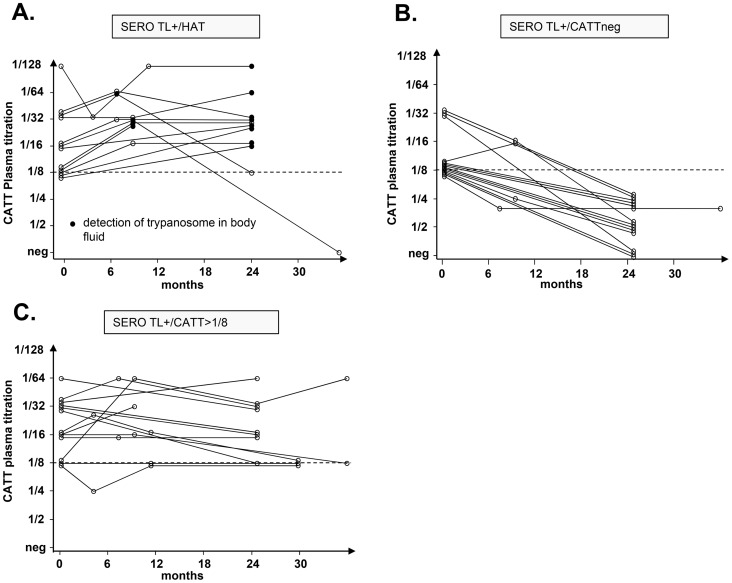
Evolution of the serological and parasitological status in SERO TL+ subjects.The progression of CATT end titers over time is presented for individuals who were confirmed as HAT patients during their follow-up (A.), plain circles indicate that trypanosomes were detected by microscopy in blood or cervical lymph nodes; individuals with decreasing CATT responses (B.) and individuals who maintained high serological responses to the CATT during the follow-up period (C.).